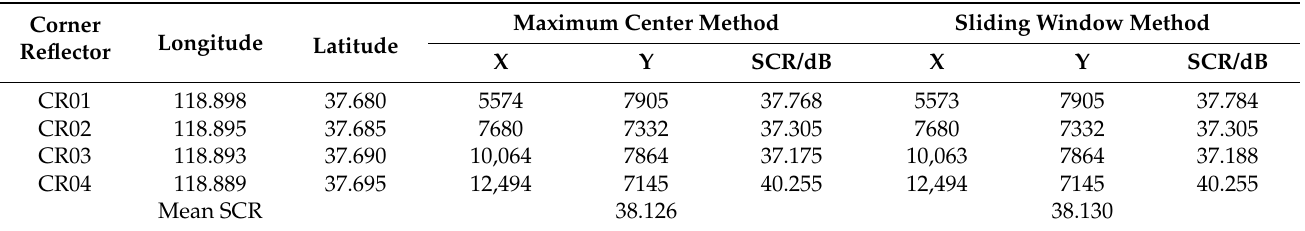
Table 8. Image coordinates and SCRs of corner reflectors based on the original center position and the improved center